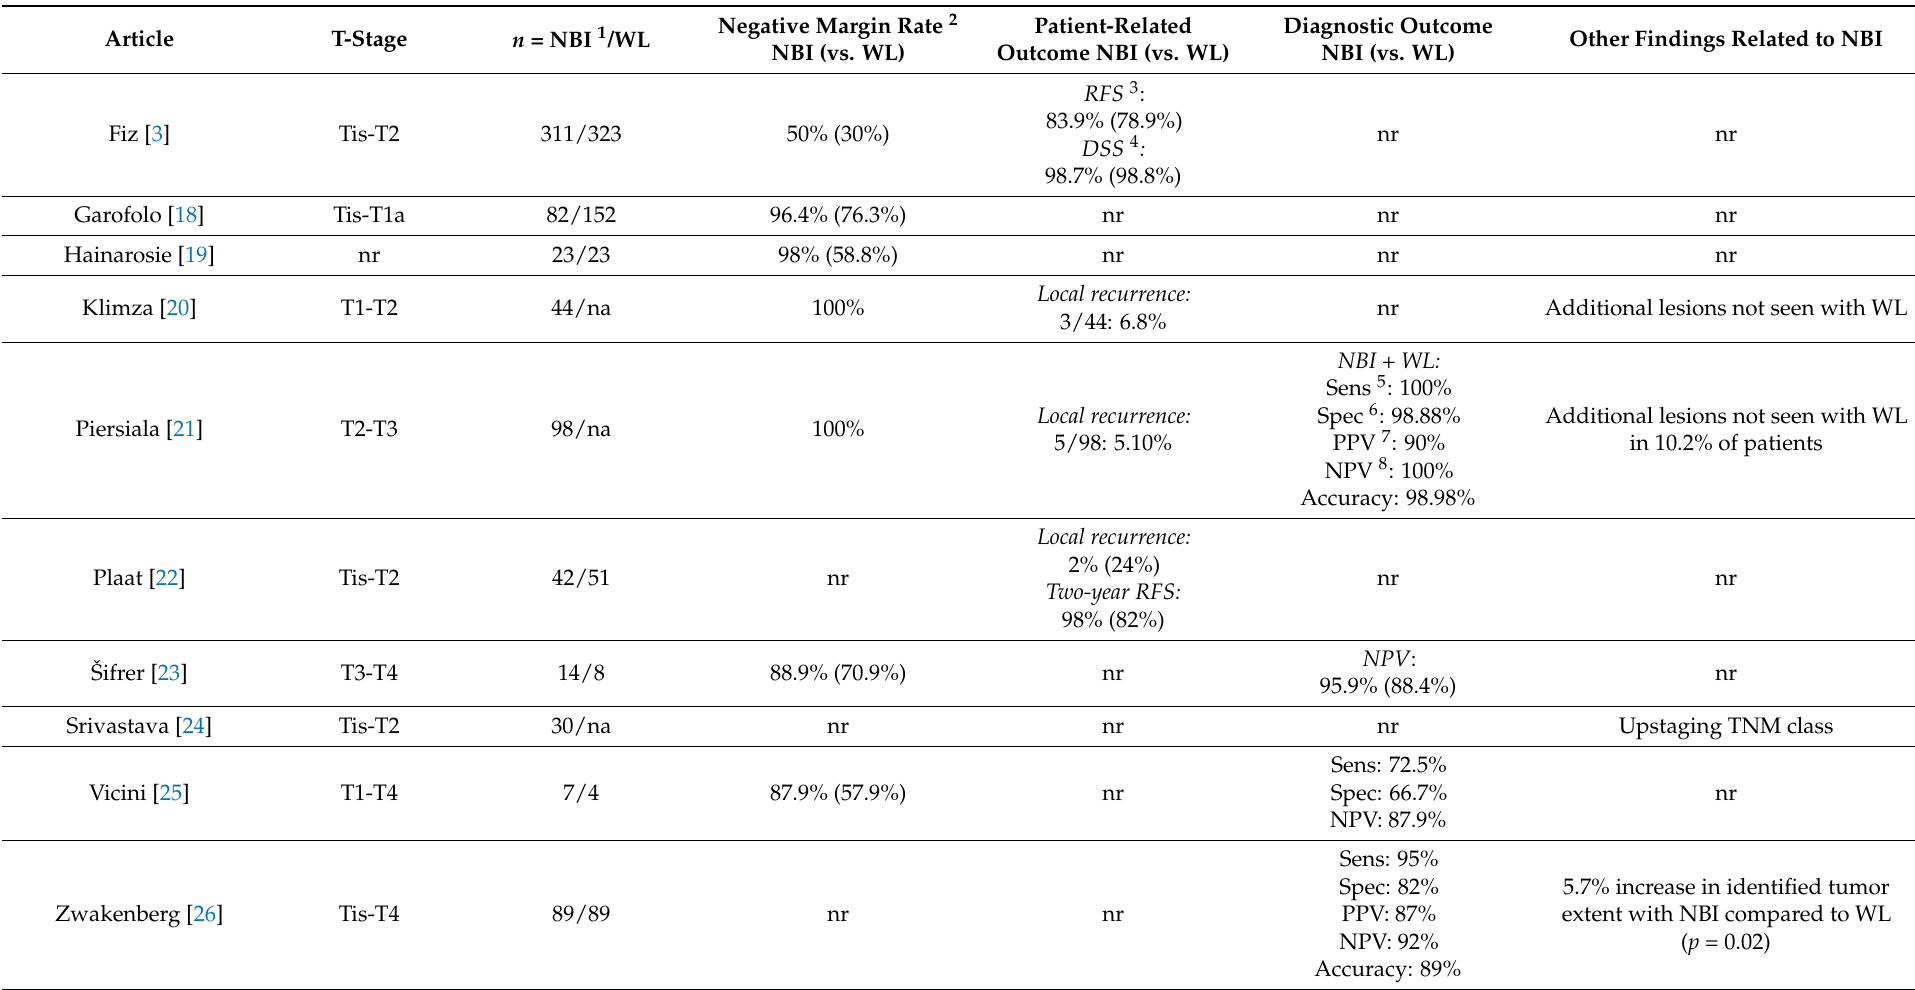
Table 2. Narrow-band imaging (NBI) trial